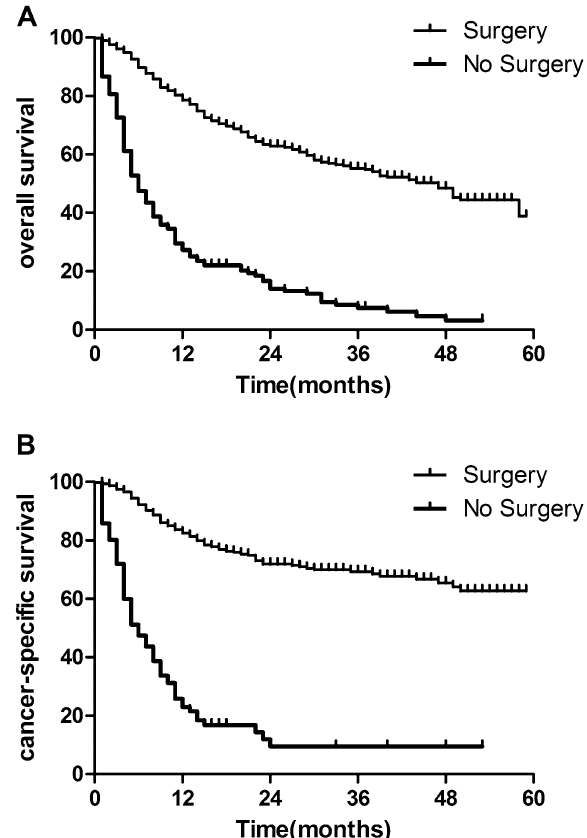
Figure 1. Kaplan–Meier analysis of OS ( A ) and CSS ( B ) in the surgery and no surgery